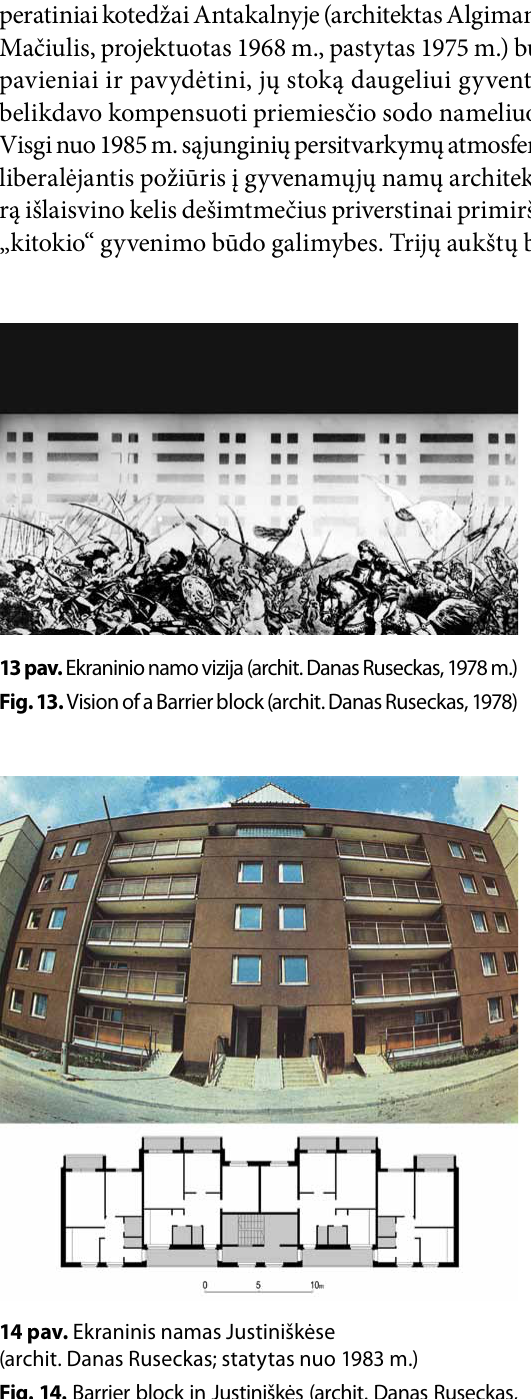
Fig. 12. Multipurpose building near Sanavanorių av. (archit.